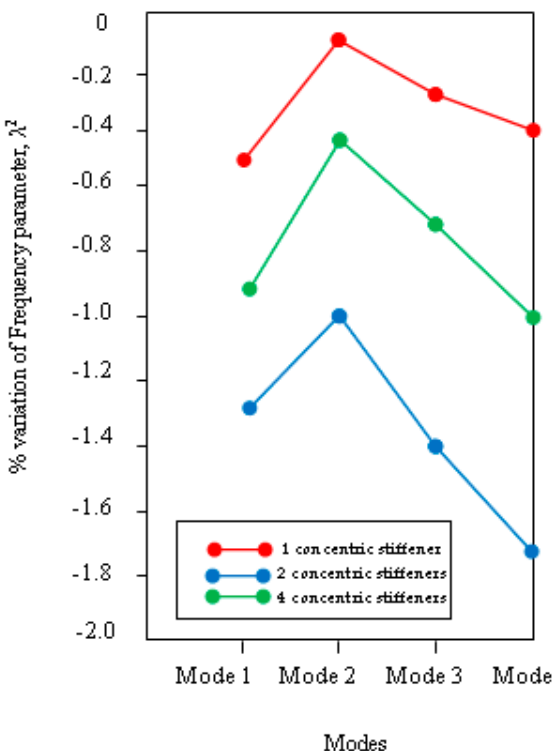
Figure 5. Comparison of % variation of natural frequency parameter with different modes for plate with taper ratio, T x = 0.00 and with different attachments of rectangular stiffener patches.